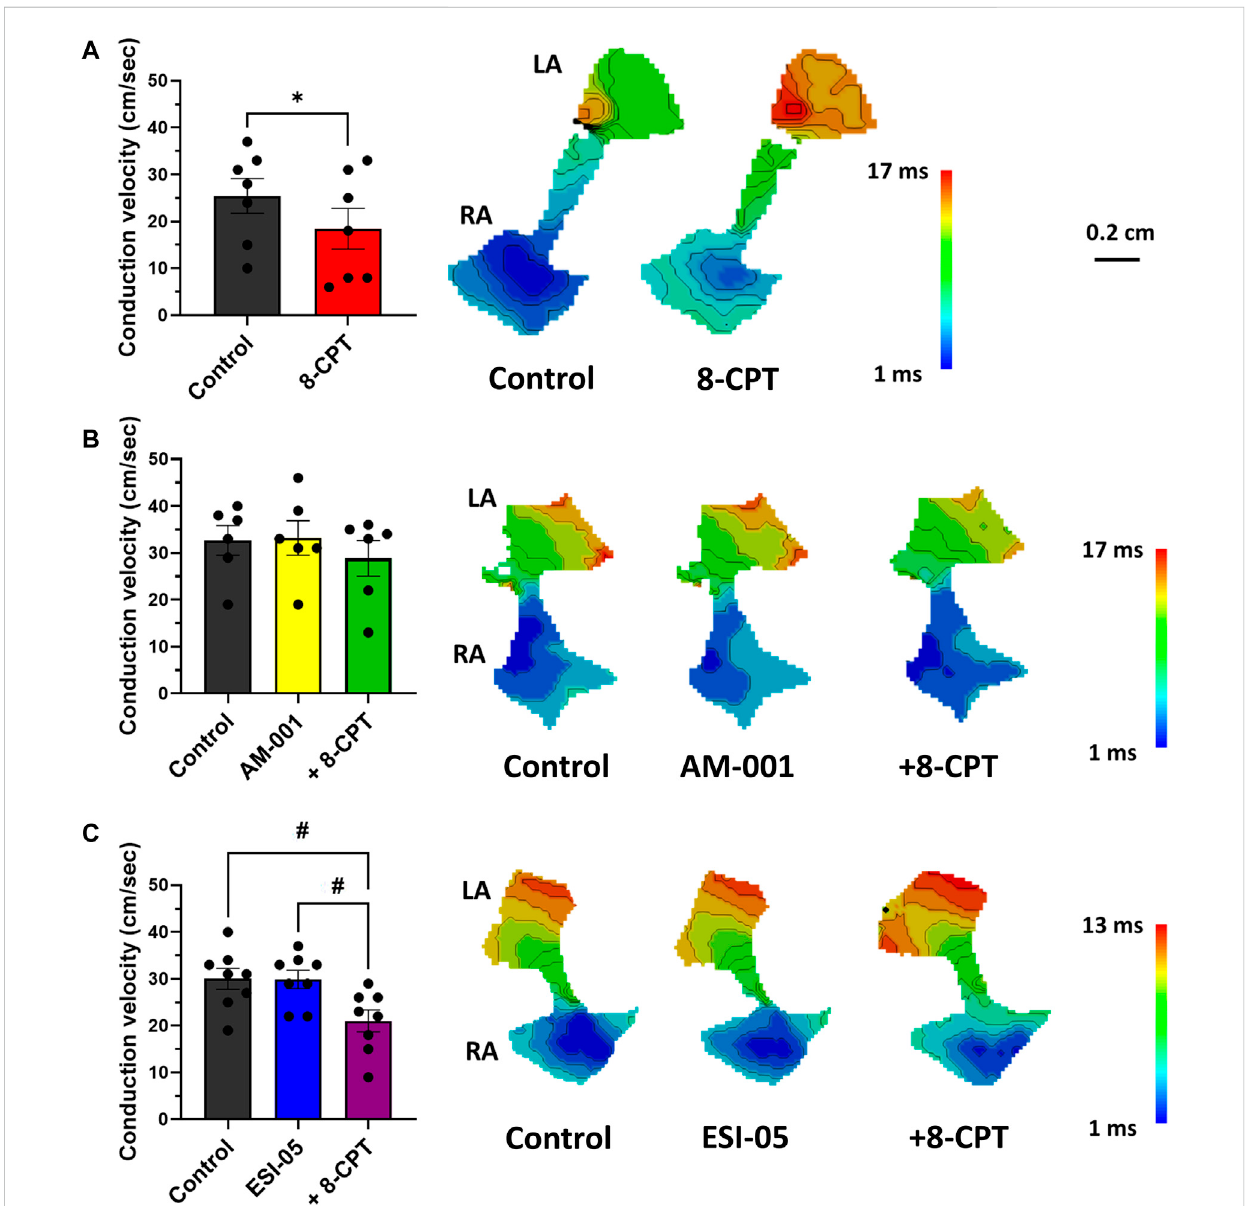
FIGURE 5 Quanti fi cation of conduction velocity (CV) using activation time (AT) maps during 7 Hz pacing. (A) Activation of EPAC1&2 leads to a slowing of CV and an increase of total activation time (TAT). ( N = 7) (B) Activation of EPAC2 pathway do not lead to any change in CV and TAT. ( N = 5) (C) Activation of EPAC1 pathway induced a slowing of CV and increased TAT. ( N = 10) Statistical differences were determined by paired t-tests [ (A) ; * p < 0.05], and by ANOVA with Tukey post hoc test and Kruskal Wallis with Dunn post hoc test [ (B,C) ; # p < 0.05; ## p <